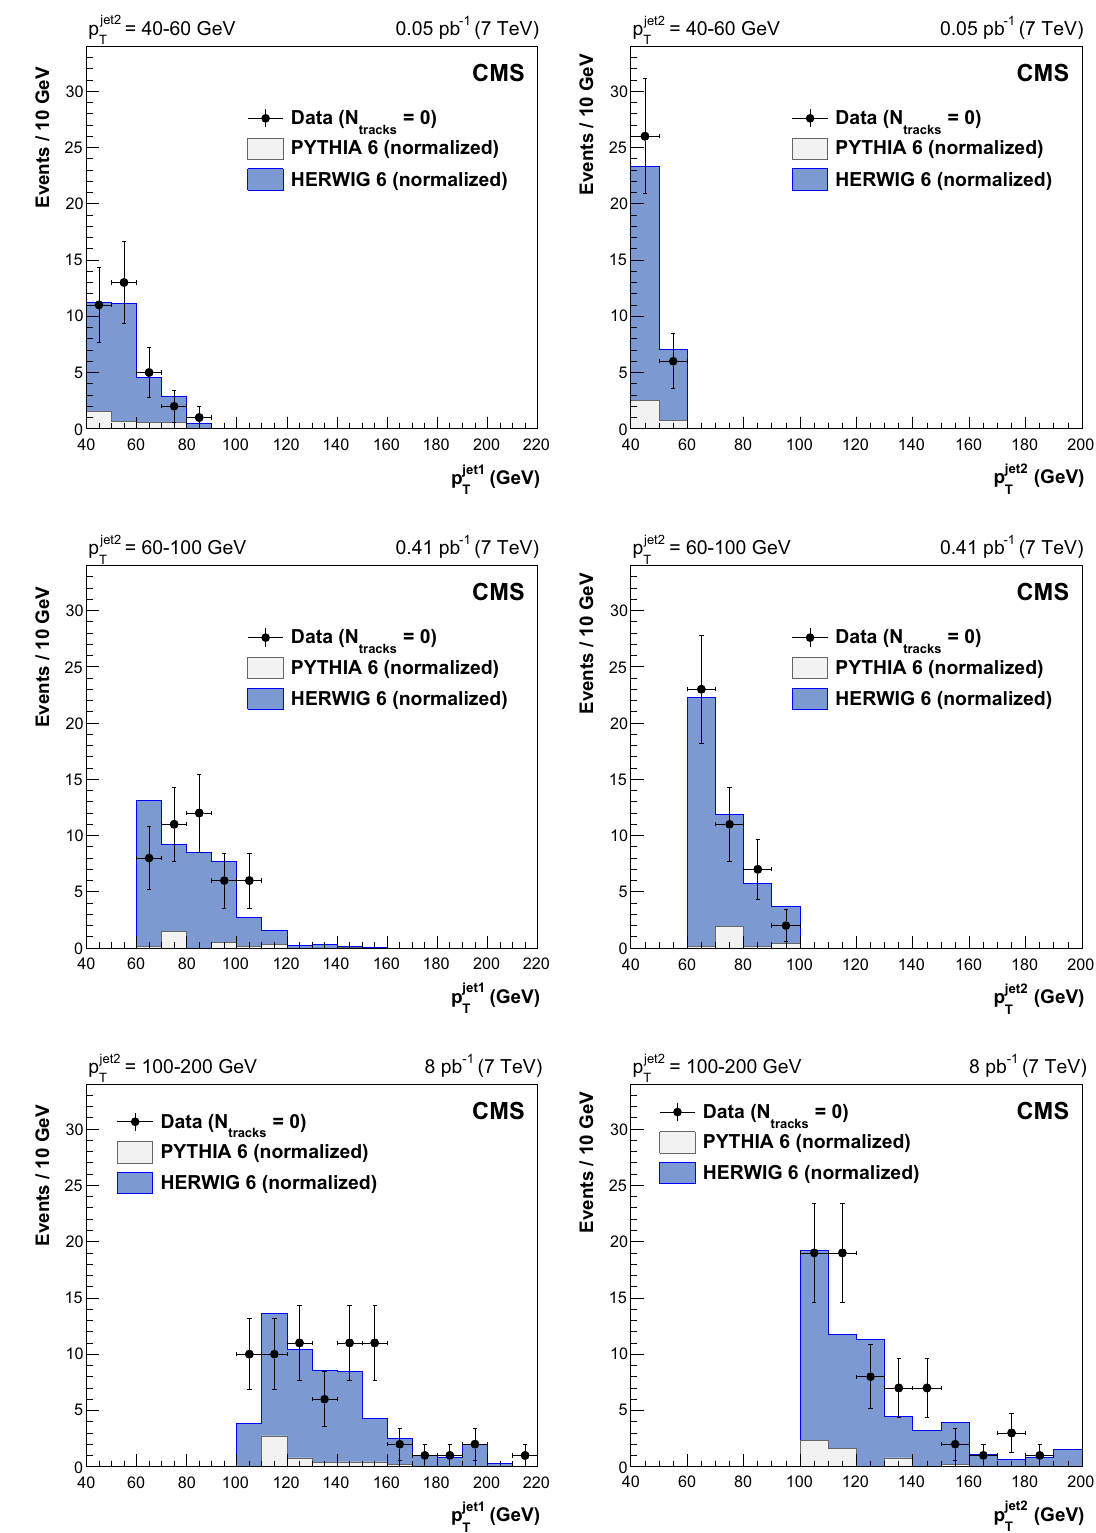
Fig. 4 Transverse momentum distributions, uncorrected for detector the gap region | η | < 1, compared to predictions of pythia 6 (inclusive dijets) and herwig 6 (CSE jet-gap-jet events), normalized as in Fig. 3. effects, of the leading jet (left) and the second-leading jet (right) in three = 40–60, 60–100, and 100–200 GeV (from top The error bars indicate the statistical dijet samples with p jet2 T to bottom) after all selections, for events with no tracks reconstructed in